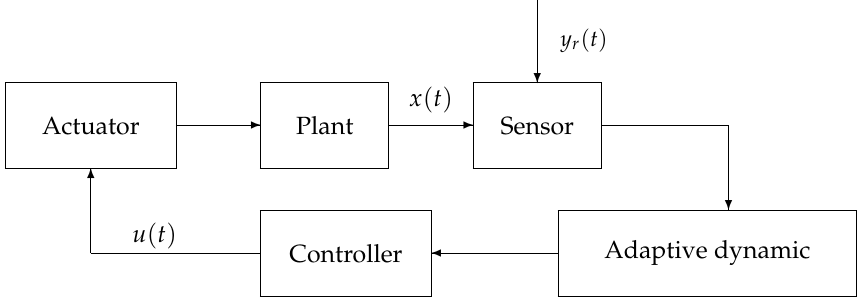
Figure 1. The fixed-time tracking control